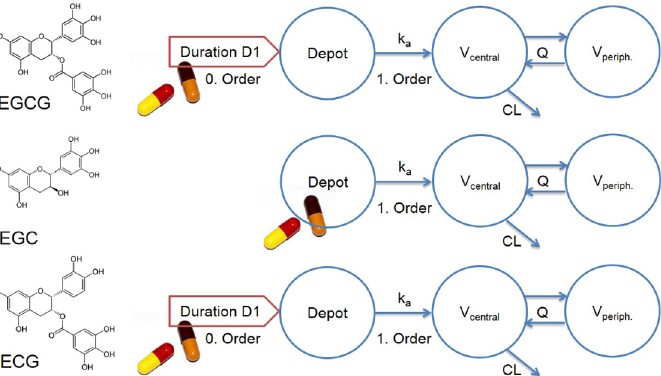
Fig 5. PopPK models. Structures of the three independently developed PopPK models employing two-compartment nested models with different descriptions of the absorption processes for the gallate (EGCG, ECG) and non-gallate (EGC) green tea catechins. The depot compartment (Depot) represents the gastrointestinal tract, from where the catechins are absorbed into the central volume of distribution (V central ), representing the blood and quickly equilibrating tissues such as liver and kidney. V periph. : peripheral volume of distribution, D1: dissolution duration, ka: absorption time constant, Q: intercompartmental clearance, CL: clearance from V central .